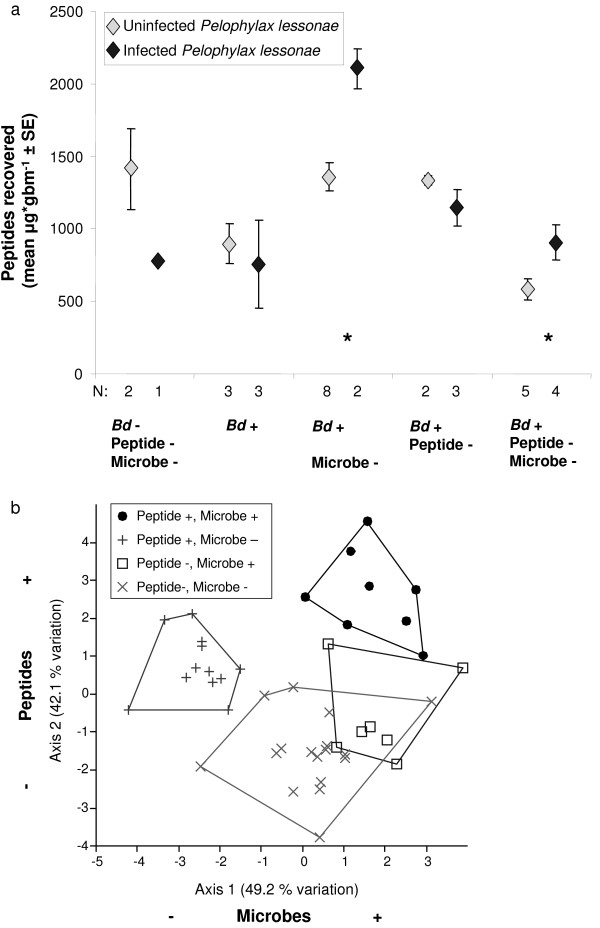
The effect of infection with B. dendrobatidis (Bd) on the quantity of skin peptides recovered and the effect of treatment on skin peptide profiles from Pelophylax lessonae. (a) Asterisks indicate treatments with statistically significant differences between infected and uninfected frogs. (b) A canonical variates analysis scatter plot showing treatment effects on skin peptide profiles. Axes correspond to frog treatment: Peptides reduced (−) by norepinephrine to intact (+), and microbes reduced (−) by antibiotics to intact (+).